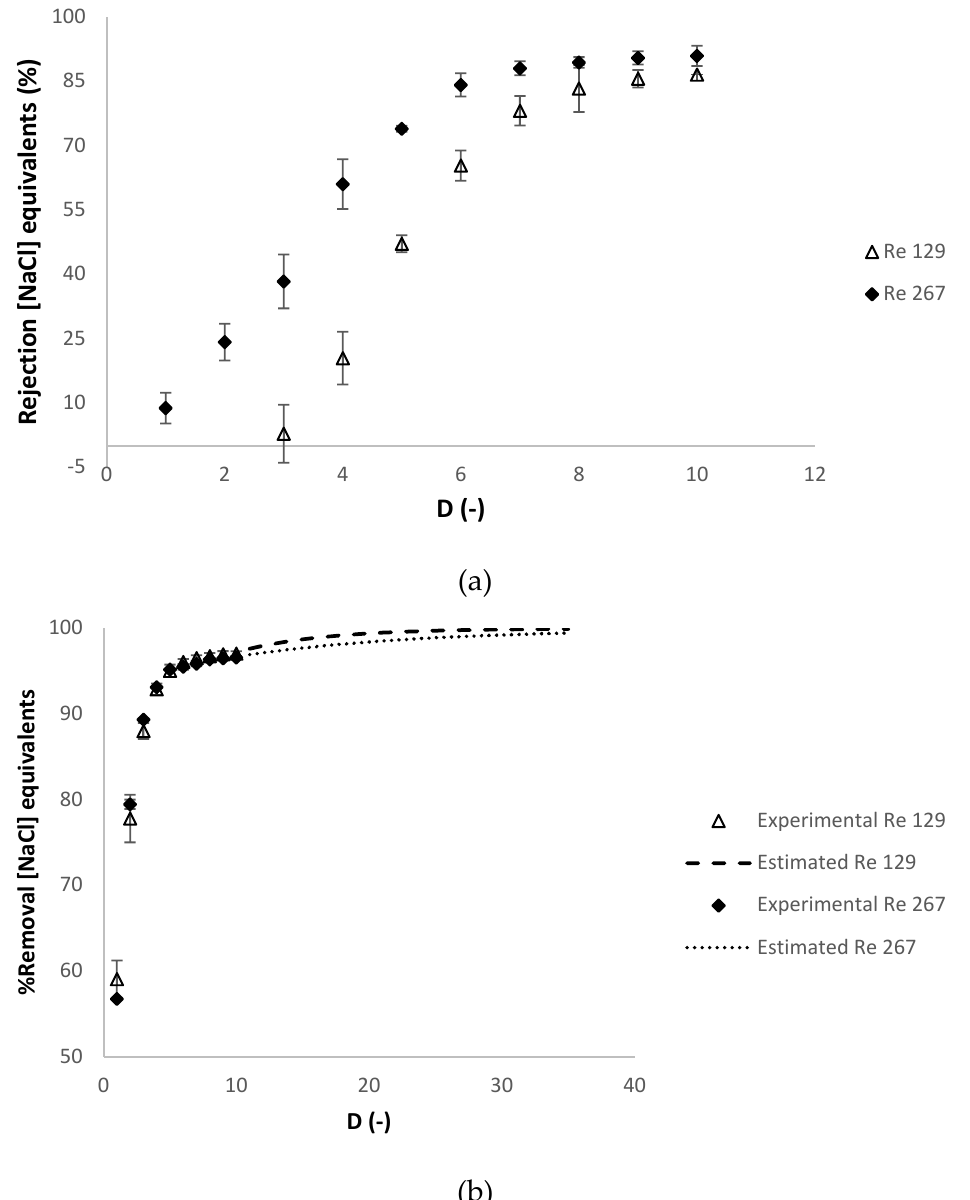
Figure 7. Dia-ultrafiltration at different Reynolds numbers at the feed compartment (129 and 267) experiments with (diluted) arabinoxylans fraction as feed, at 40 °C, without relaxation procedure: ( a ) R NaCl (% NaCl.eq), apparent rejection in sodium chloride equivalents and ( b ) percentage of removal of charged contaminants in sodium chloride equivalents (NaCl.eq) against the D (-) diafiltration volume. Each analysis had duplicate measurements.